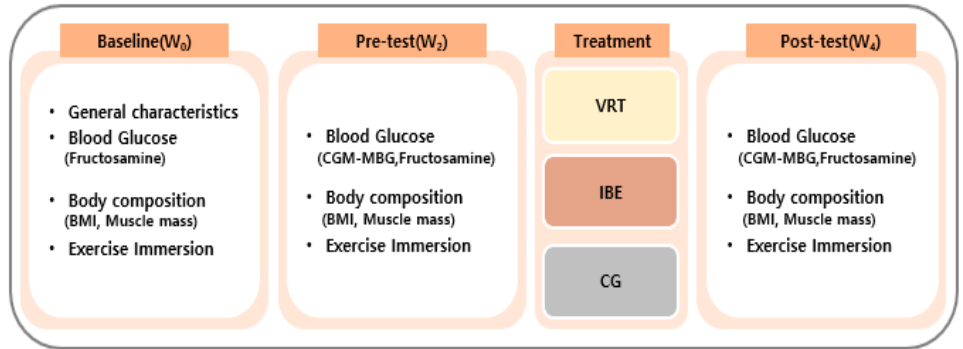
Figure 1. Study design. Baseline (W 0 ): baseline measurements. Pre-test (W 2 ): measurements two weeks before the intervention. Post-test (W 4 ): measurements two weeks after the intervention. VRT: virtual reality therapy group; IBE: indoor bicycle exercise group; CG: control group; CGM- MBG: continuous glucose monitoring mean blood glucose; BMI: body mass